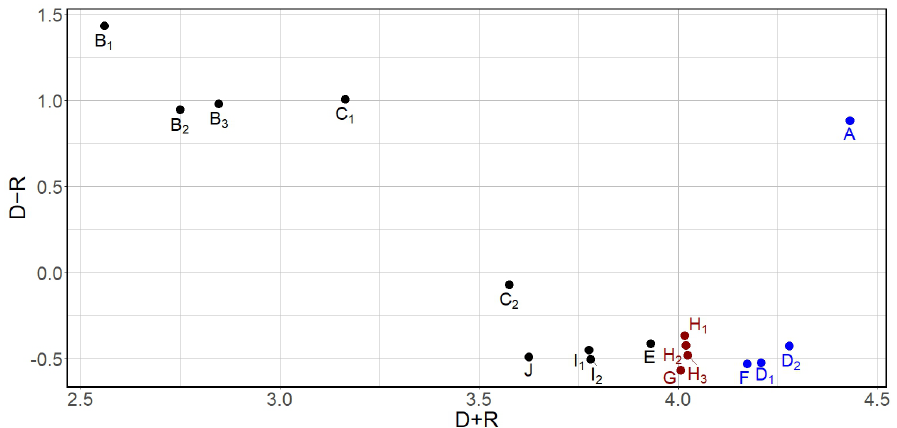
Figure 1. Final cause-and-effect